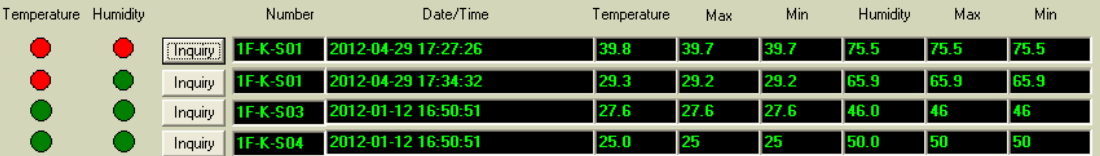
Figure 4. Temperature and humidity monitoring